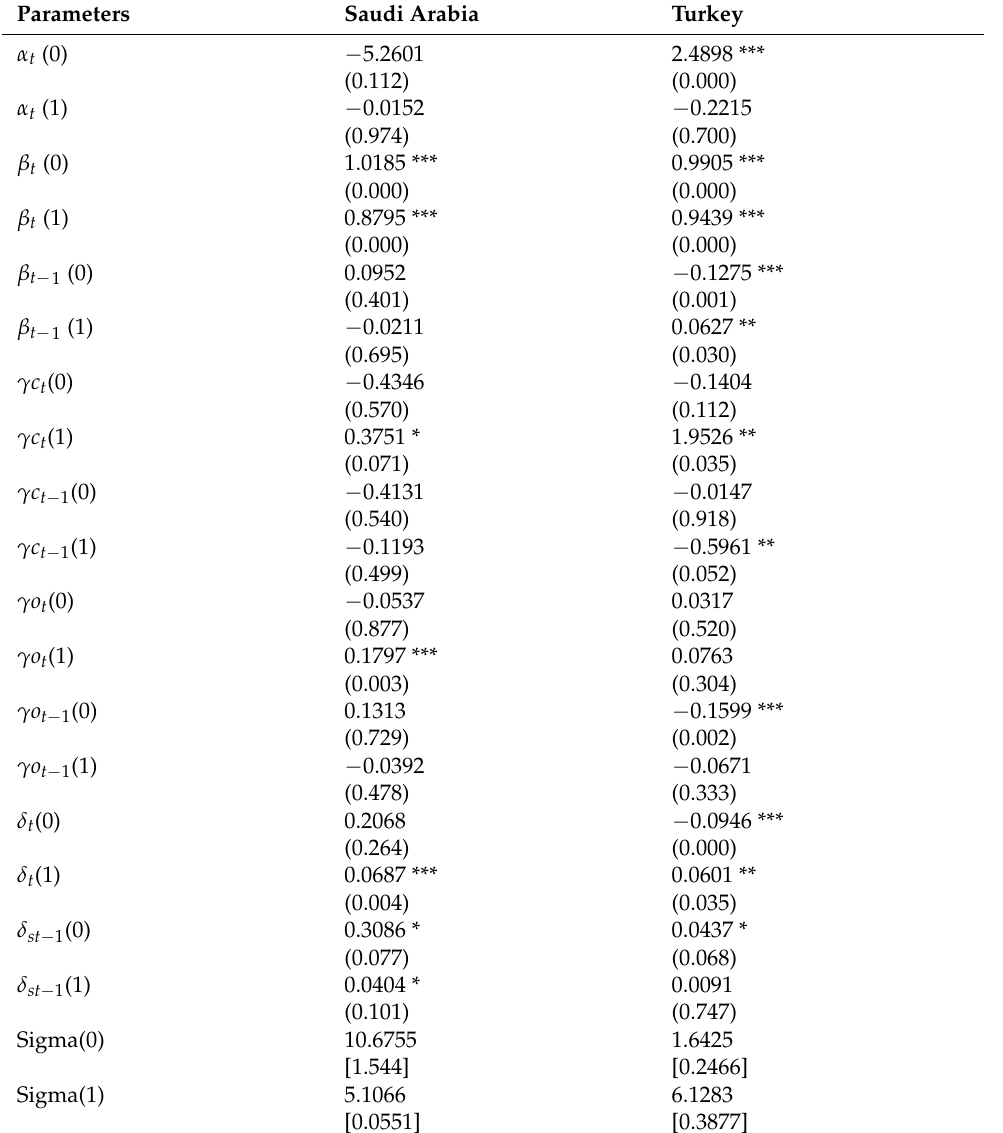
Table 6. Estimates of MS-ICAPM with oil prices, composite risk ratings, and VIX values. Model